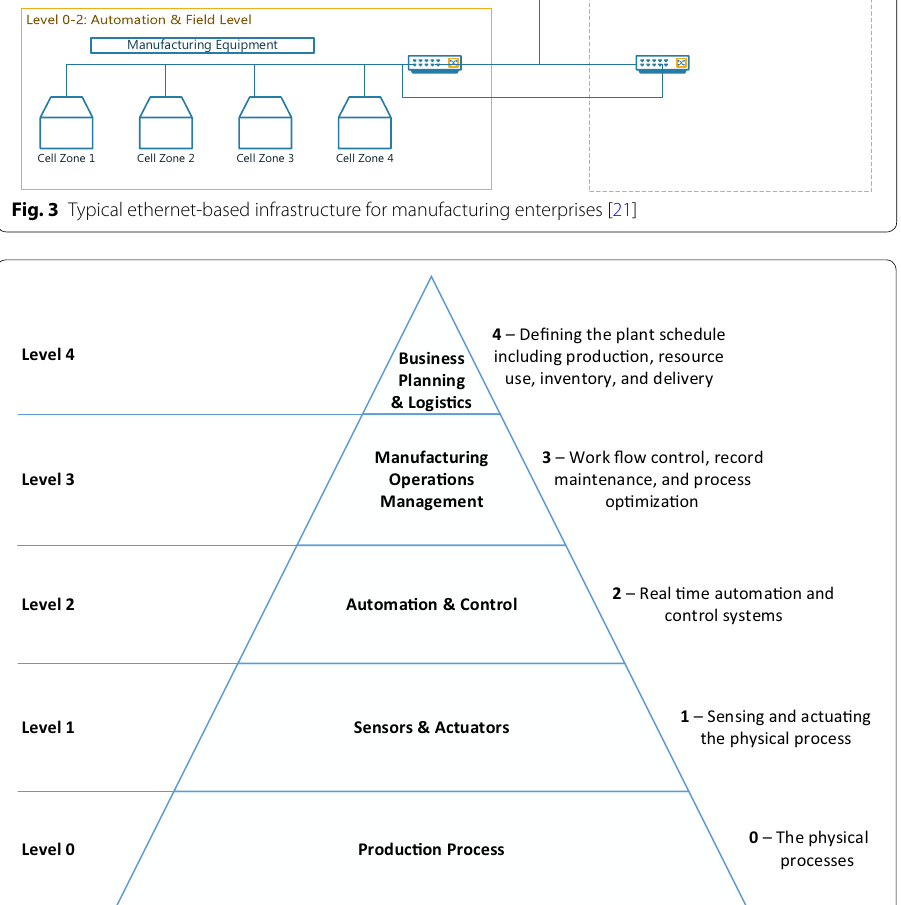
Fig. 4 The five layers of the automation pyramid (Reproduced with permission from